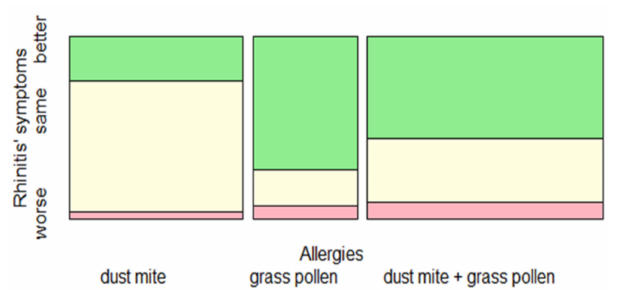
Figure 2. Change in rhinitis symptoms during the lockdown (worse, same, better), depending on allergic